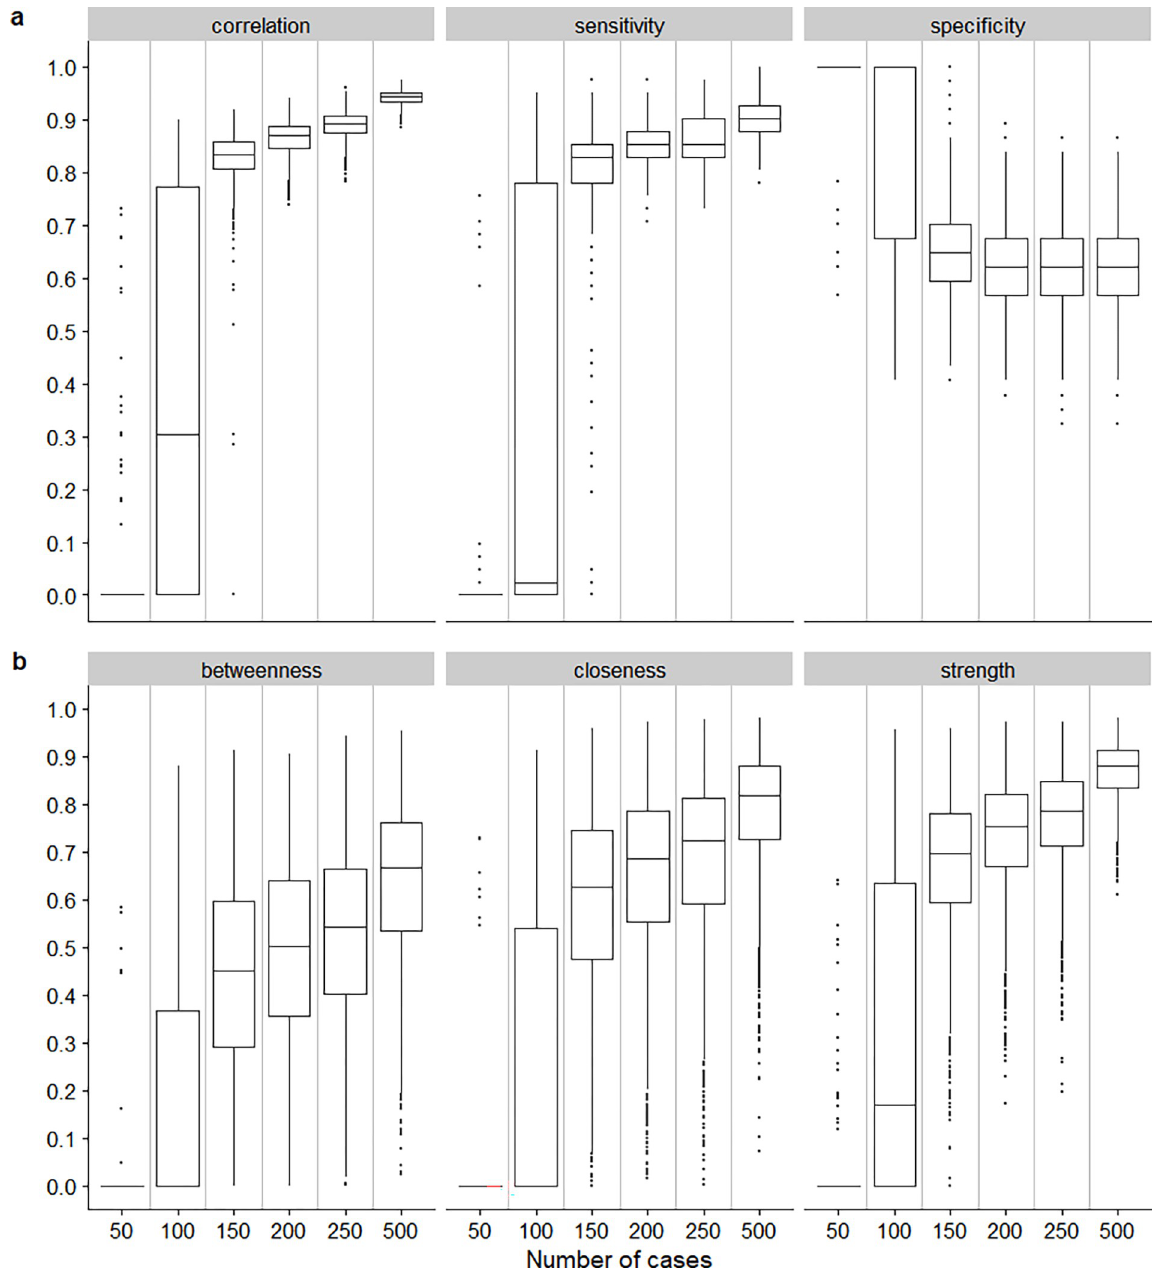
Fig 5. Boxplots of the estimated a) correlation of edge weights, sensitivity, specificity, and b) correlation of the Centrality measures between the given network and the re-estimated network with various sample size. (leg stretch and jumping) and the third strongest correlation was between Q2-Q35 (twisting and falling backward)–which supported our first hypothesis. In support of our second hypothesis, sim- ilar activities (e.g. Q33-Q34, two cycling images) were more highly correlated than dissimilar activities (e.g. Q22-Q23, getting out of bed and climbing stairs). In contrast to our third and fourth hypotheses, the most important items in the network were climbing stairs, walking with groceries and mopping the floor, and not shovelling soil or high-spinal flexion angle activities.